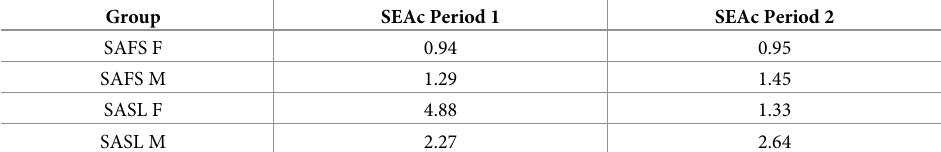
Table 3. Corrected Standard Ellipse Area (SEAc) for each period and group estimated with 75% maximum likelihood.